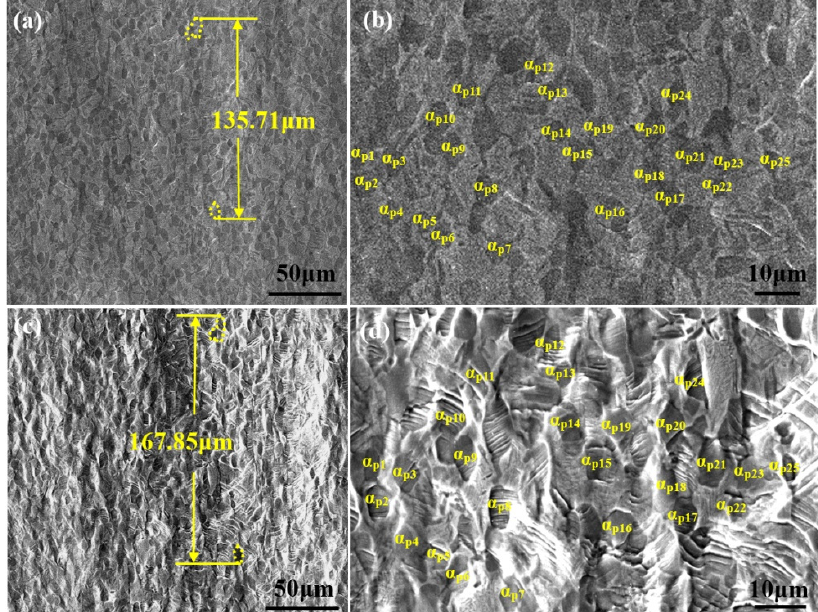
Figure 8. In situ SEM images of bimodal samples; ( a ) a selected area at position A; ( b ) magnified image showing the morphologies of α p phase at position A; ( c ) the area in ( a ) stretched to position B; ( d ) magnified image illustrating the deformation within α p phase at position B.